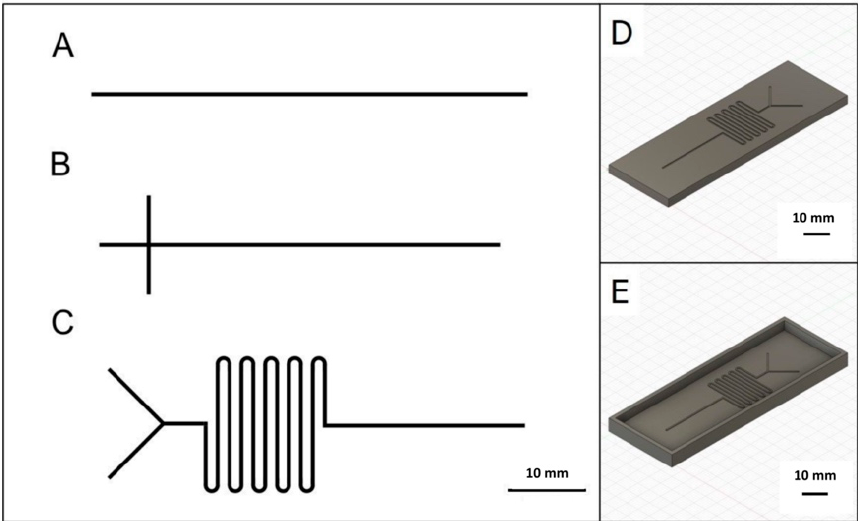
Figure 1. Microfluidic designs with 0.5 mm microchannel width and 0.15 mm microchannel depth. ( A ) Straight microchannel, ( B ) crossed junction microchannel, ( C ) Serpentine mixer microchannel. 3D rendering of ( D ) a microfluidic chip and ( E ) a microfluidic mold. The three designs were fabricated via three-dimensional fused deposition modelling (3D FDM), computer numerical control (CNC) milling and laser engraving.